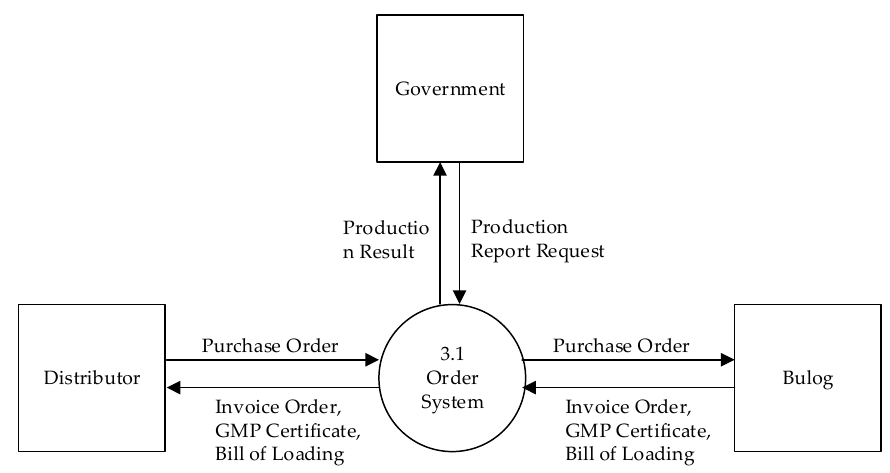
Figure 8. Diagram 3 level 2.